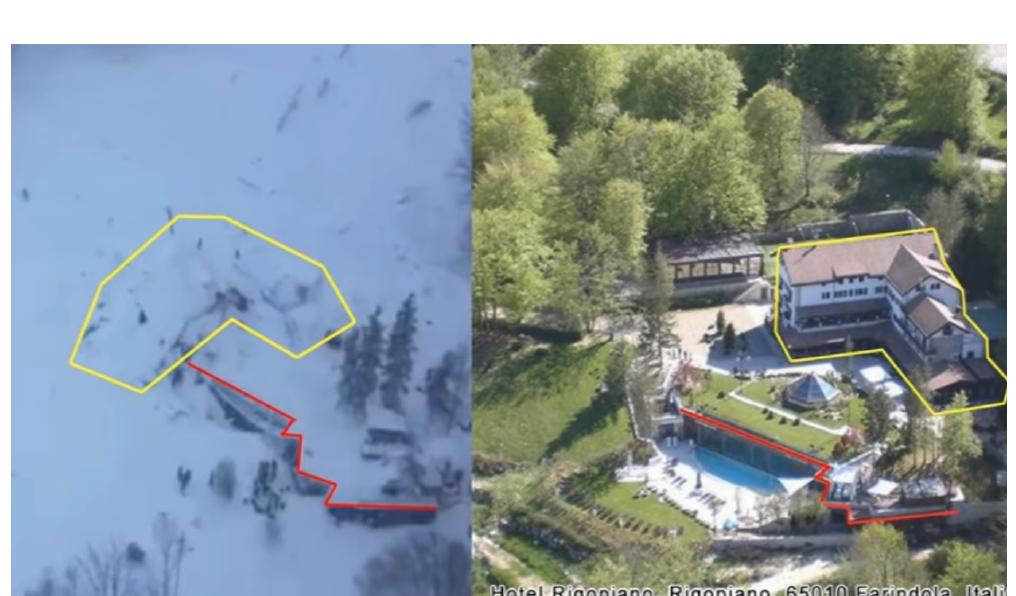
Figure 9. Position of the destroyed Hotel Rigopiano (yellow lines) before ( right panel ) and after the avalanche ( left panel ) relative to the structurally stable edge of the spa area (red lines). Still image downloaded from [11] and reproduced under Creative Commons license CC-BY 3.0, extracted from Youtube video uploaded by TvSEI